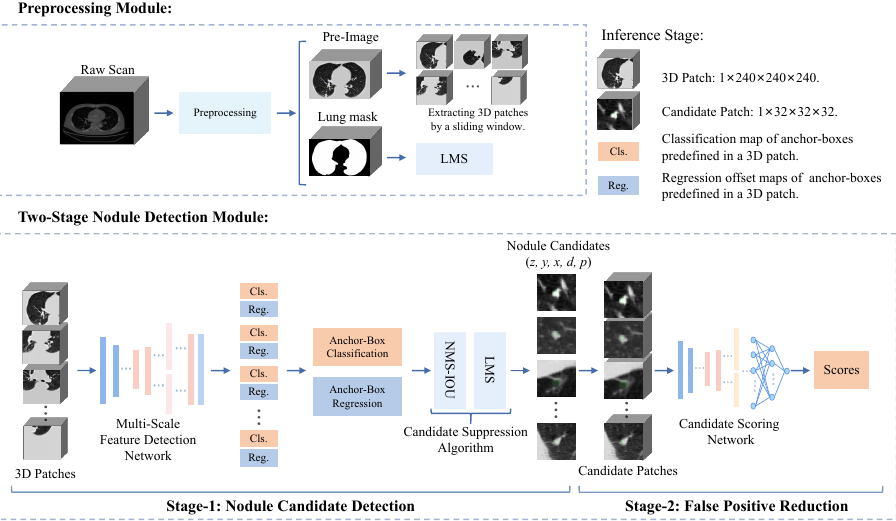
Figure 3. Overall flowchart of the proposed end-to-end nodule CAD system. It includes a prepro- cessing module to identify a region of interest in a raw LDCT scan, and a two-stage nodule detection module to generate nodule candidates and reduce false